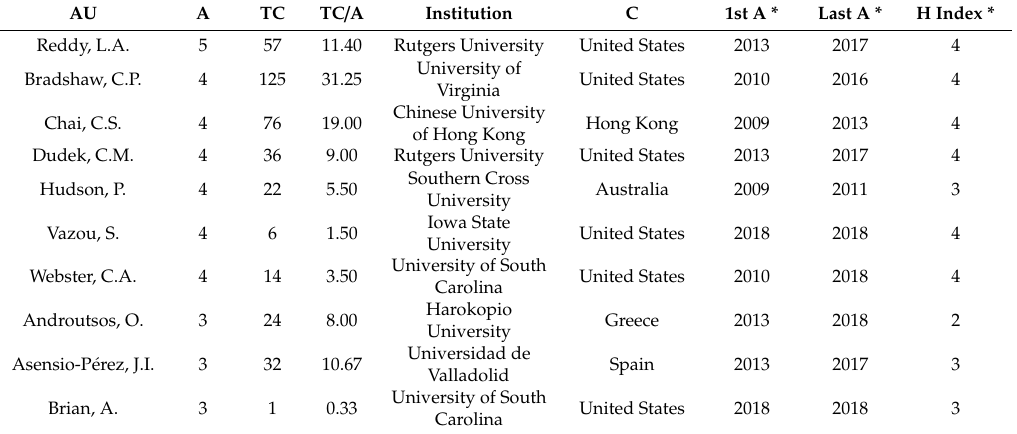
Table 5. Most productive authors in number of articles on the impact of the university classroom on managing the socio-educational well-being